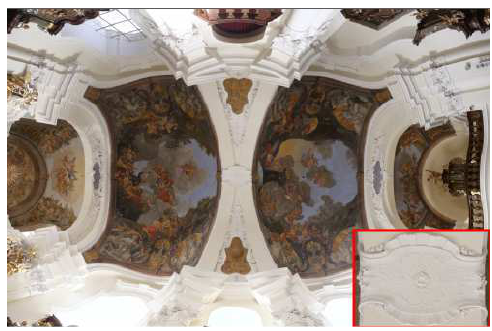
Figure 5. Panoramic image from Microsoft ICE